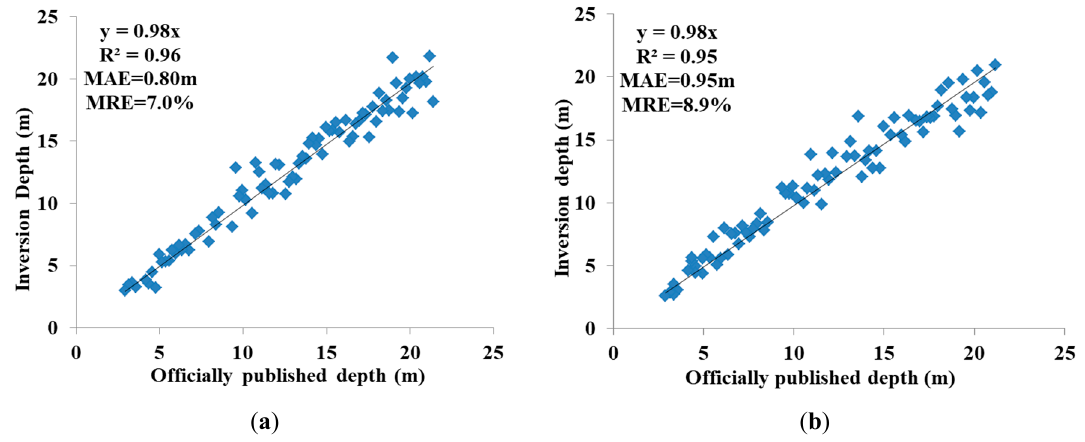
Figure 12. ( a ) Scatter plot of control points; ( b ) scatter plot of validation points.